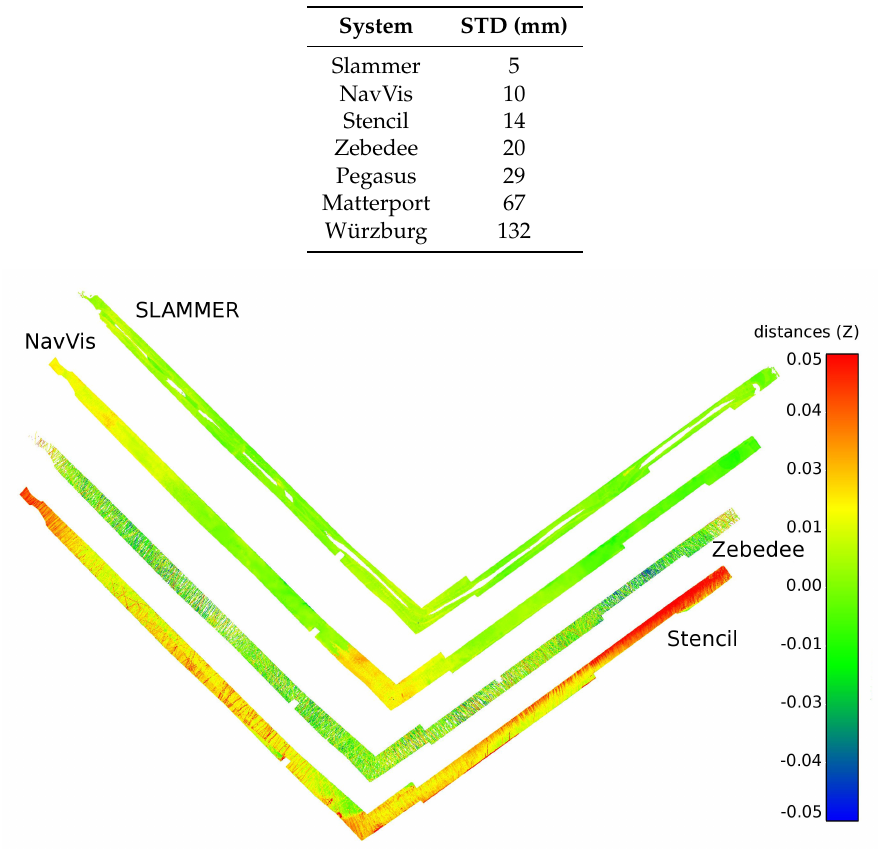
Table 4. The standard deviations (STD) of the floor elevation from the reference. Best result first.